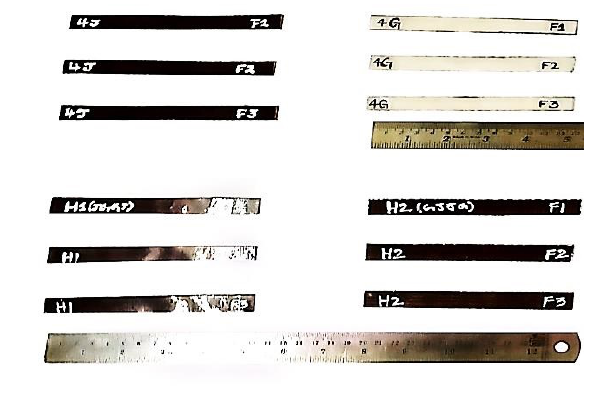
Fig. 4. Flexural test specimen of four types of composite laminates.